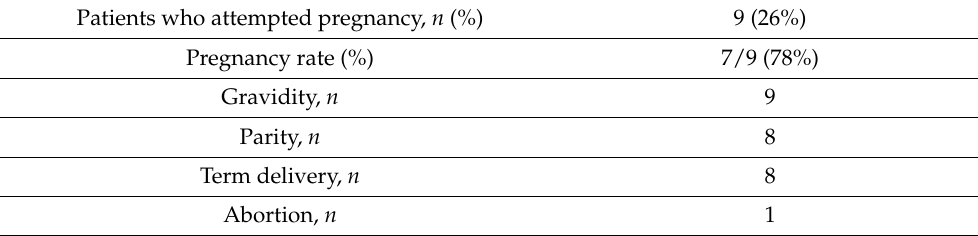
Table 3. Obstetrical